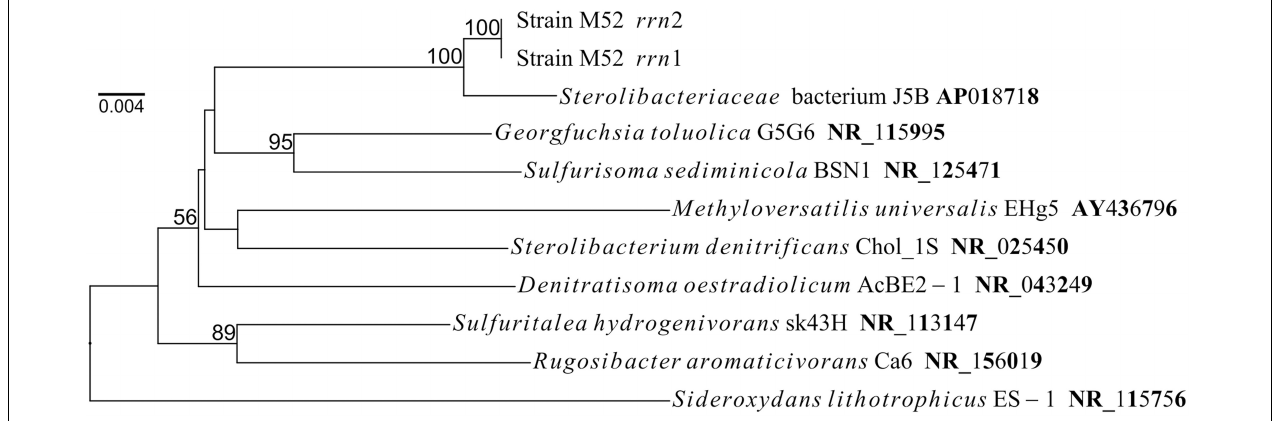
FIGURE 1 | Phylogenetic position of two copies of the 16S rRNA gene in the genome of strain M52. Numbers on nodes represent percentage values (greater than 50%) of 1000 bootstrap resampling.